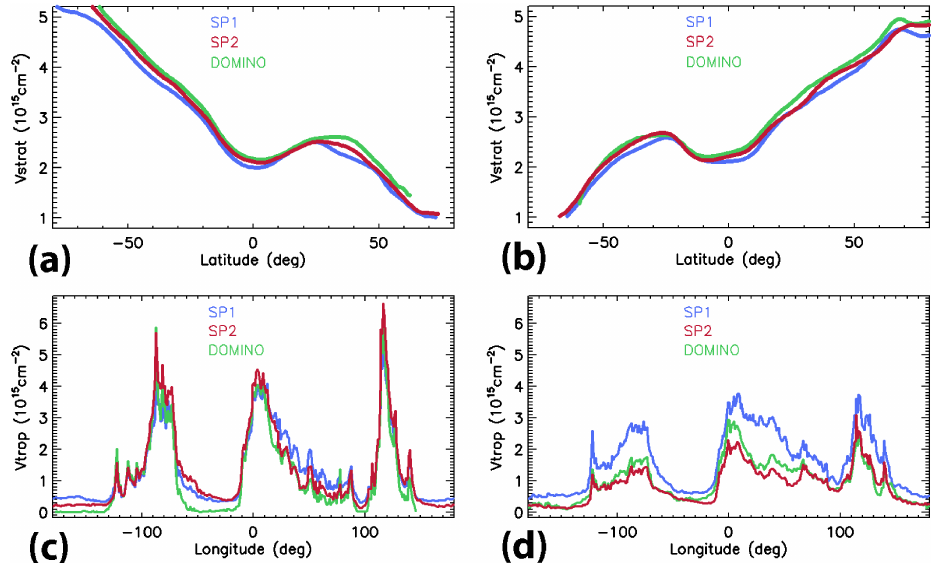
Fig. 9. Monthly mean NO 2 comparisons of SP1 (blue), SP2 (red), and DOMINO (green): (a) January stratospheric zonal mean, (b) July stratospheric zonal mean, (c) January NH troposphere (averaged over latitudes 35 ◦ N to 55 ◦ N), (d) July NH troposphere (averaged over latitudes 35 ◦ N to 55 ◦ N). In (c) and (d) , the three regions of enhanced tropospheric NO 2 represent, from left to right, the USA, Europe, and E. Asia, respectively. All measurements used for the tropospheric means were screened to exclude cloud radiance fractions greater than